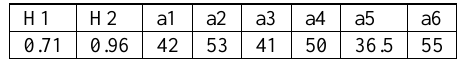
Table1. Optimal values for H - α classification boundaries.